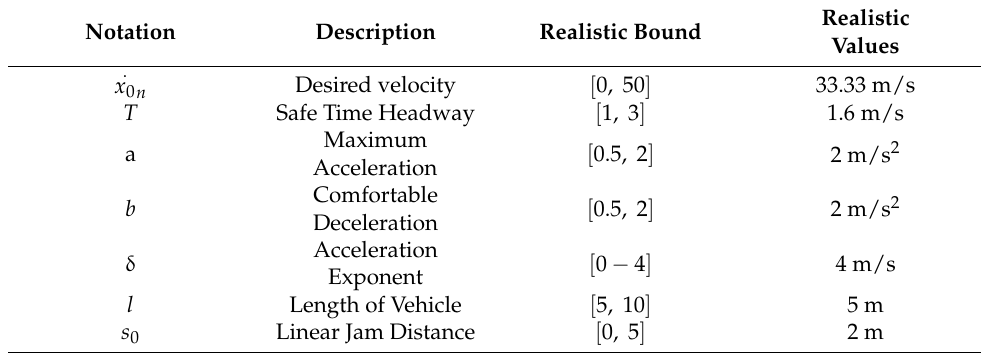
Table 1. Summary of parameters used for